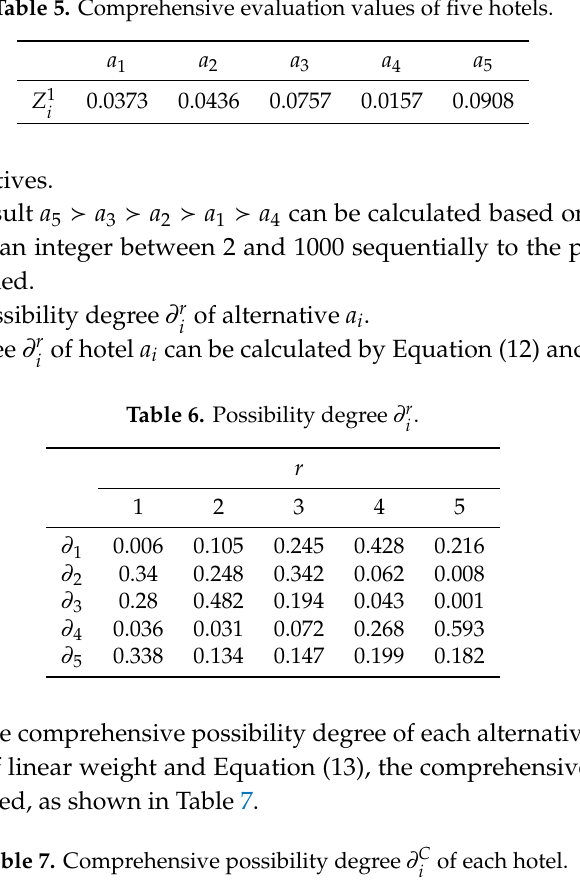
Table 7. Comprehensive possibility degree ∂ C